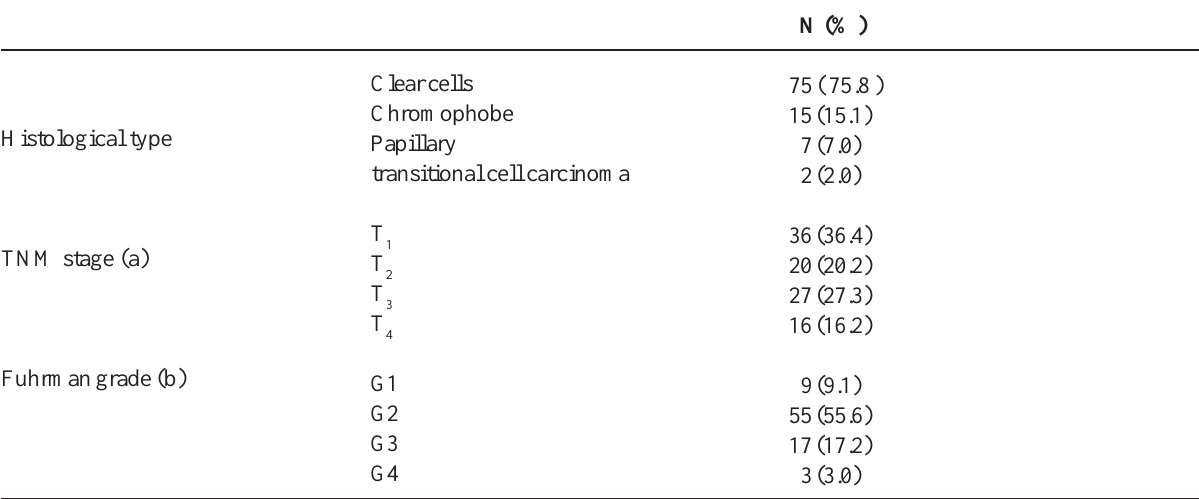
Table 2 – Pathological characteristics of 99 RCC